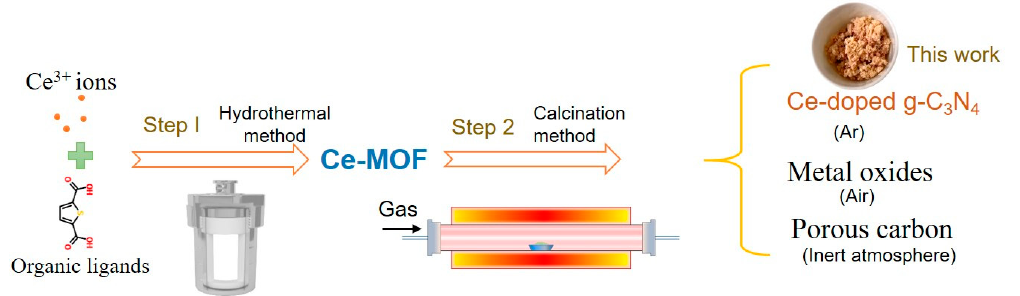
Figure 1. Schematic representation of the formation process of Ce-C 3 N 4 .